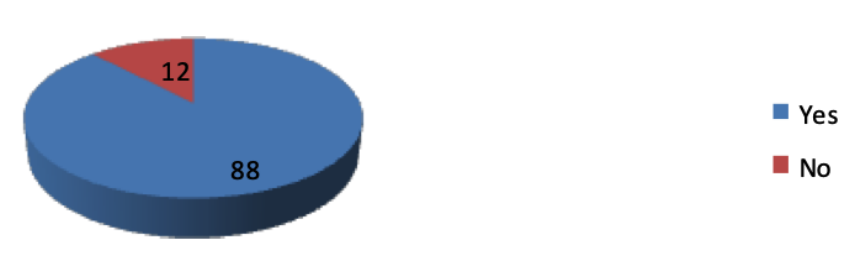
Figure 6: Training needs should be addressed through capacity